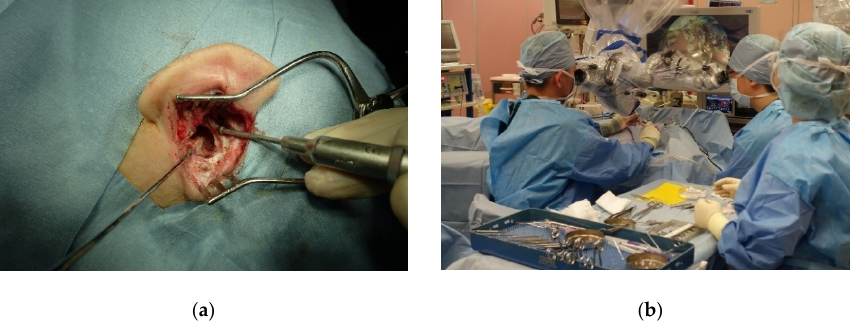
Figure 4. Microscopic ear surgery (MES) ( a ) A mastoidectomy in progress. ( b ) Surgeons performing